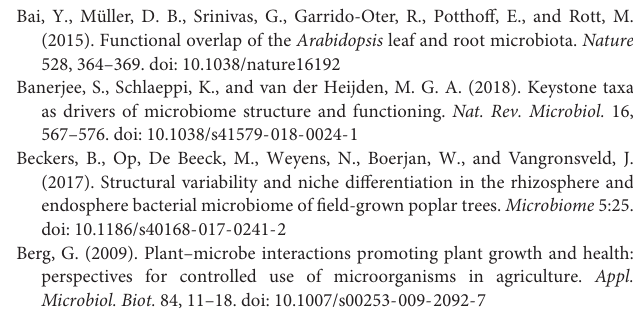
Supplementary Figure 1 | Geographic distribution of 11 regions of E. ulmoides in China. Supplementary Figure 2 | Hierarchical clustering of rhizosphere soil and bark samples of E. ulmoides based on the unweighted paired average method (UPGMA). Supplementary Figure 3 | The core microbiota of E. ulmoides was defined based on the network connection method. (a) The topology of the correlation co-occurrence network. (b) Core microbiota were defined based on closeness centrality and degree. Supplementary Figure 4 | The composition and distribution of dominant (a) and rare taxa (b)